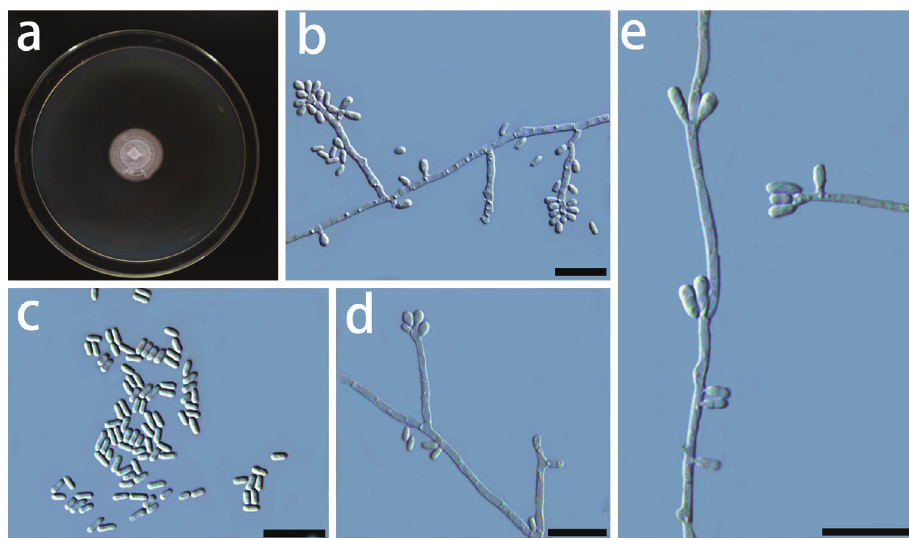
Figure 13. Morphological characters of asexual structures of Sporothrix villosa sp. nov. a fourteen-day- old culture on MEA b-e conidiophores and conidia. – Scale bars: 10